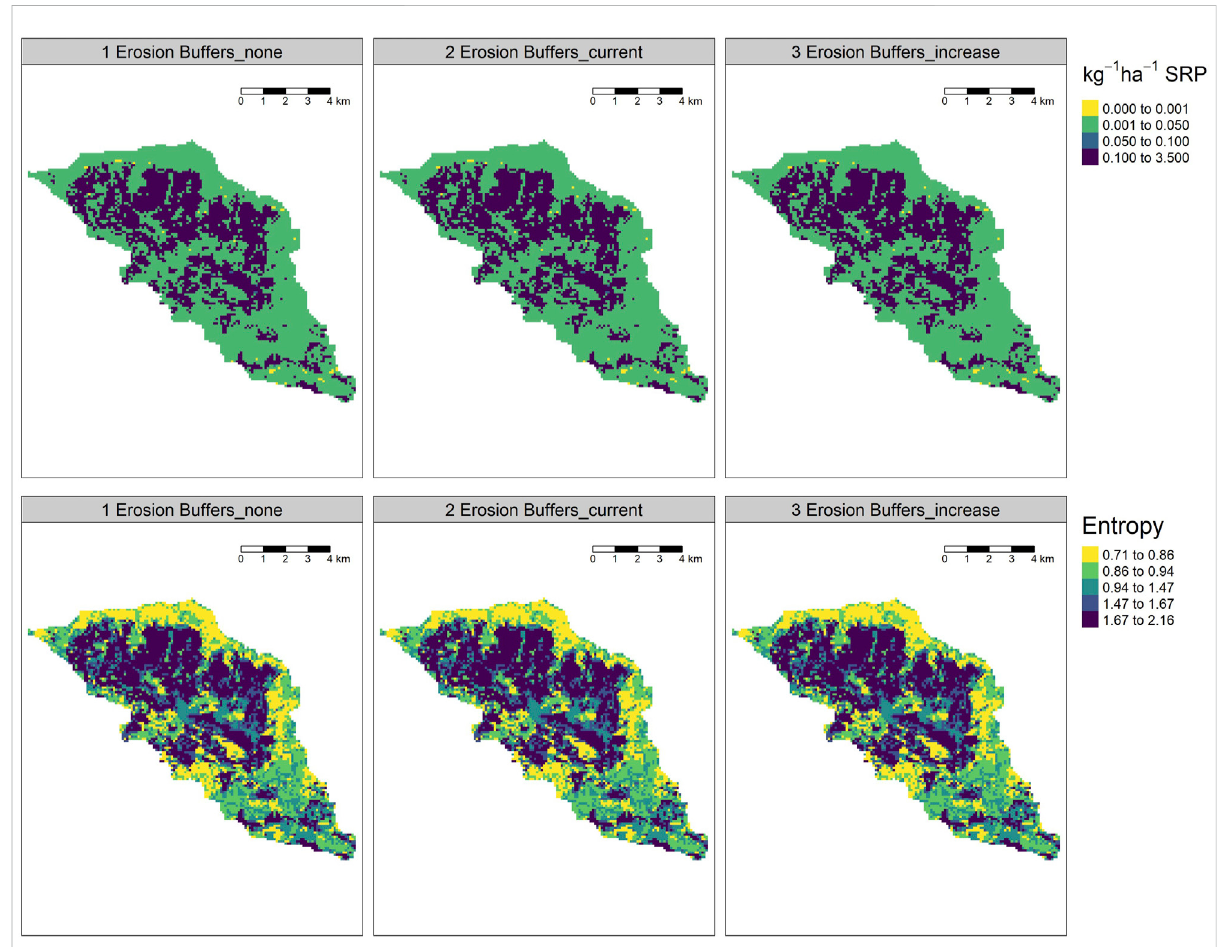
FIGURE 7 ErosionlossesintheTarlandstudycatchmentunderthreebuffermitigationscenariosandtheassociateduncertainty(entropy).Drainlossesare not shown as they are not affected by buffers in the model